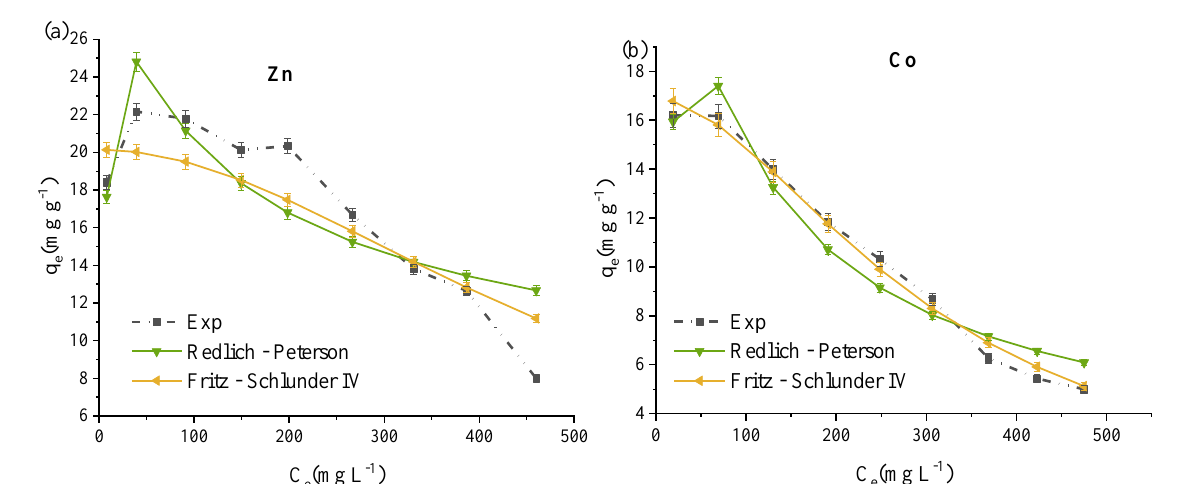
Figure 8. ZVK-FAU nonlinear adsorption isotherms plots for the simultaneous removal of five metals at 90 min, C 0 = 100 to 500 mg L − 1 and 5 g L − 1 zeolite loading for ( a ) Zn and ( b ) Co. Table 4. ZVK-FAU nonlinear adsorption isotherms ( C 0 = 100 to 500 mg L − 1 at 90 min and 5 g L − 1 adsorbent